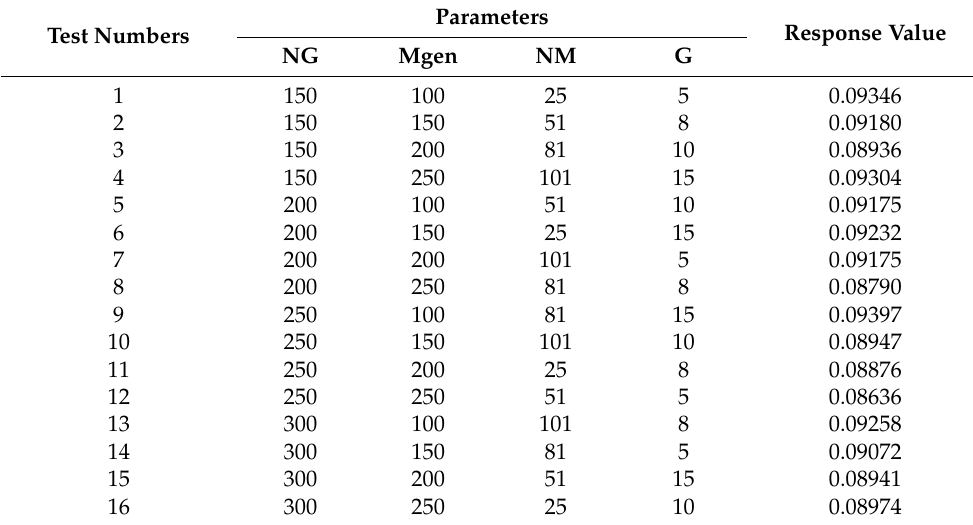
Table 4. Orthogonal matrix and response value.